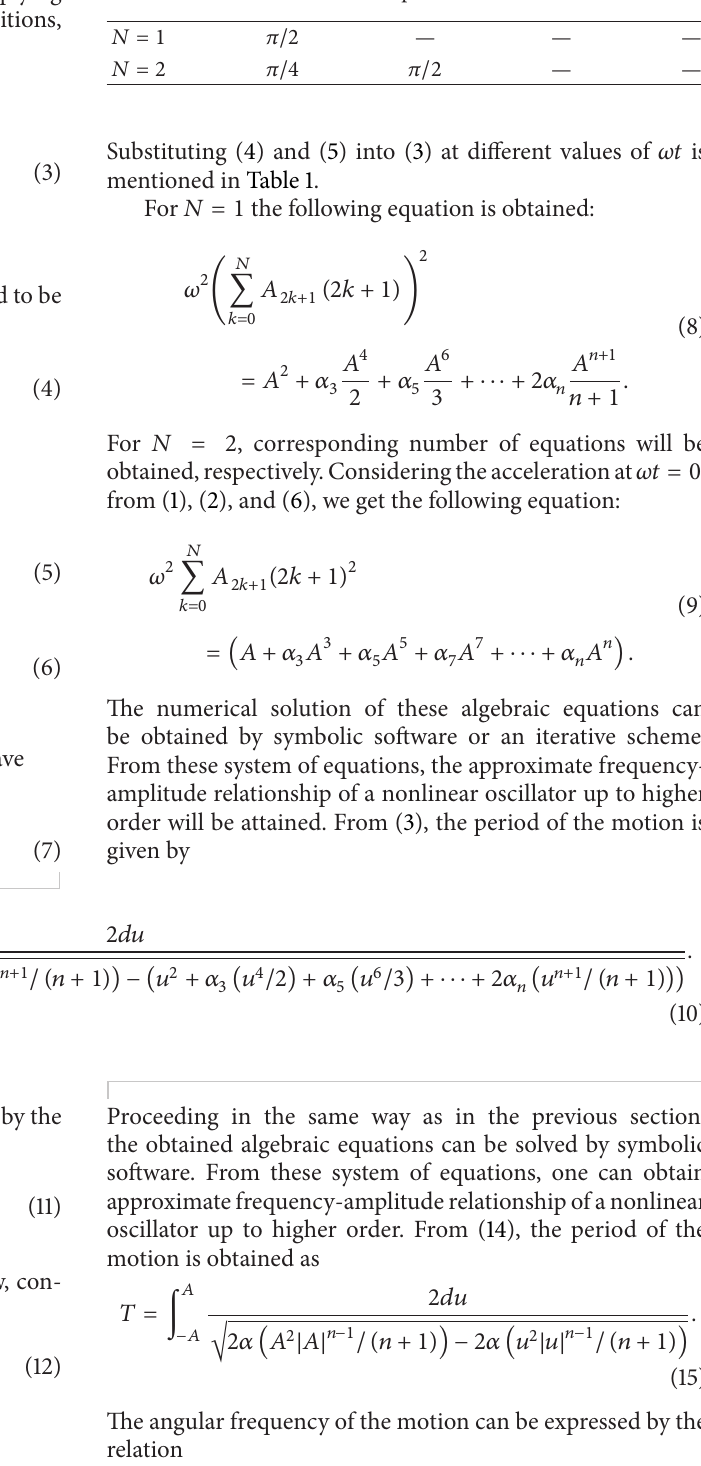
Table 1: Collocation points for different 𝜔𝑡